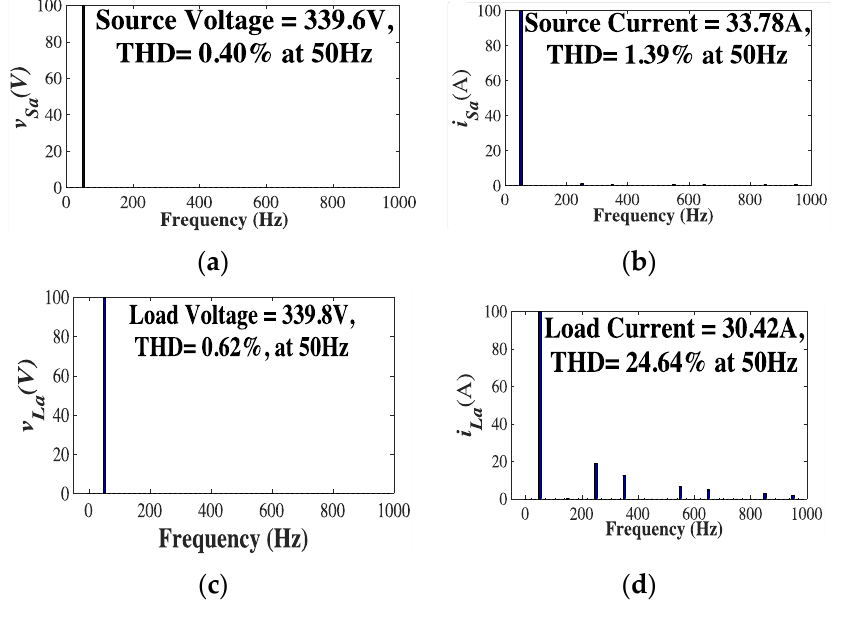
Figure 10. ( a – d ) THD analysis of v Sa , i Sa , v La and i La . Table 4. THD comparison of v Sa , i Sa , v La , i La with AKWSOMCC based VSC controls. Parameters